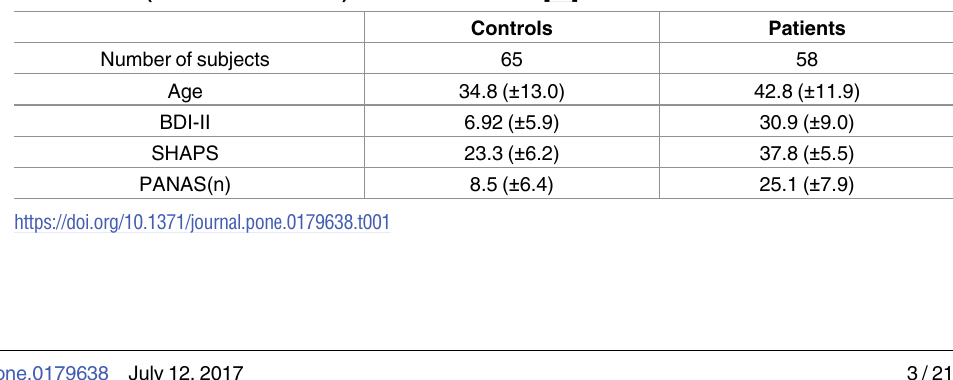
Table 1. Mean ( ± standard deviation) of clinical